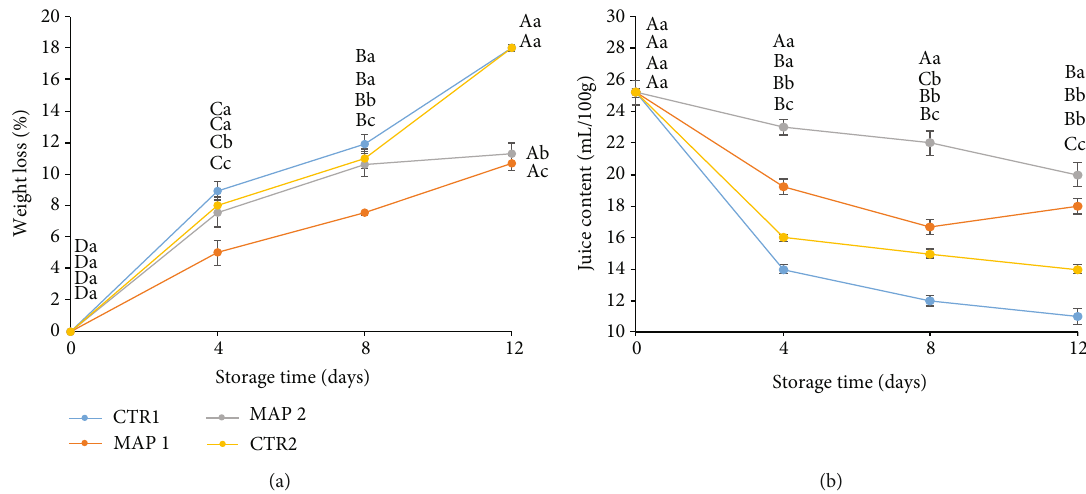
Figure 1: Pomological traits of mulberry fruit at 0, 4, 8, and 12 days of storage at 4 ± 1 ° C and 90 ± 5 % RH (relative humidity) after all treatments. (a) Weight loss, %. (b) Juice content, mL/100g. Means ± SD with di ff erent letters are signi fi cantly di ff erent at p ≤ 0 : 05 using Tukey ’ s HSD test. Di ff erent lowercase letter denotes signi fi cant di ff erences ( p ≤ 0 : 05 ) among di ff erent treatments for the same sampling time. Letter “ a ” or “ A ” denotes the highest value. Di ff erent capital letters denote signi fi cant di ff erences ( p ≤ 0 : 05 ) among di ff erent sampling times for the same